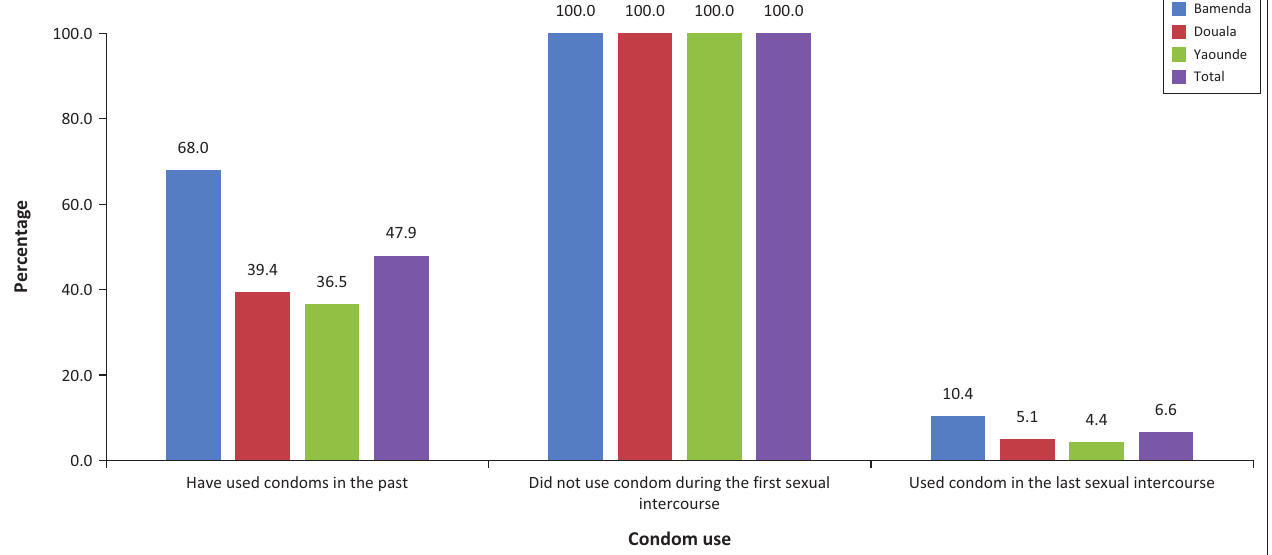
FIGURE 1: History of condom use among street children stratified by region. The figure shows percentages based on each city, for example, 68 % of participants only in Bamenda have used condoms in the past.